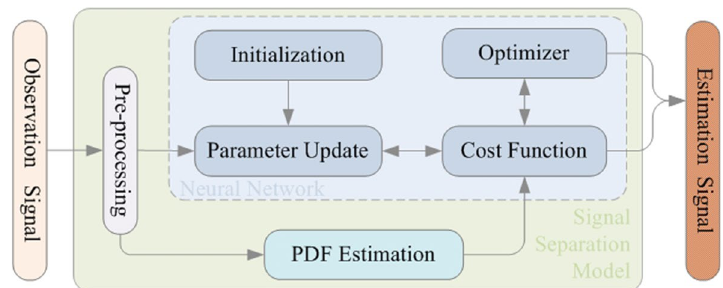
Fig. 2 The topological structure diagram of the separation methodology of this